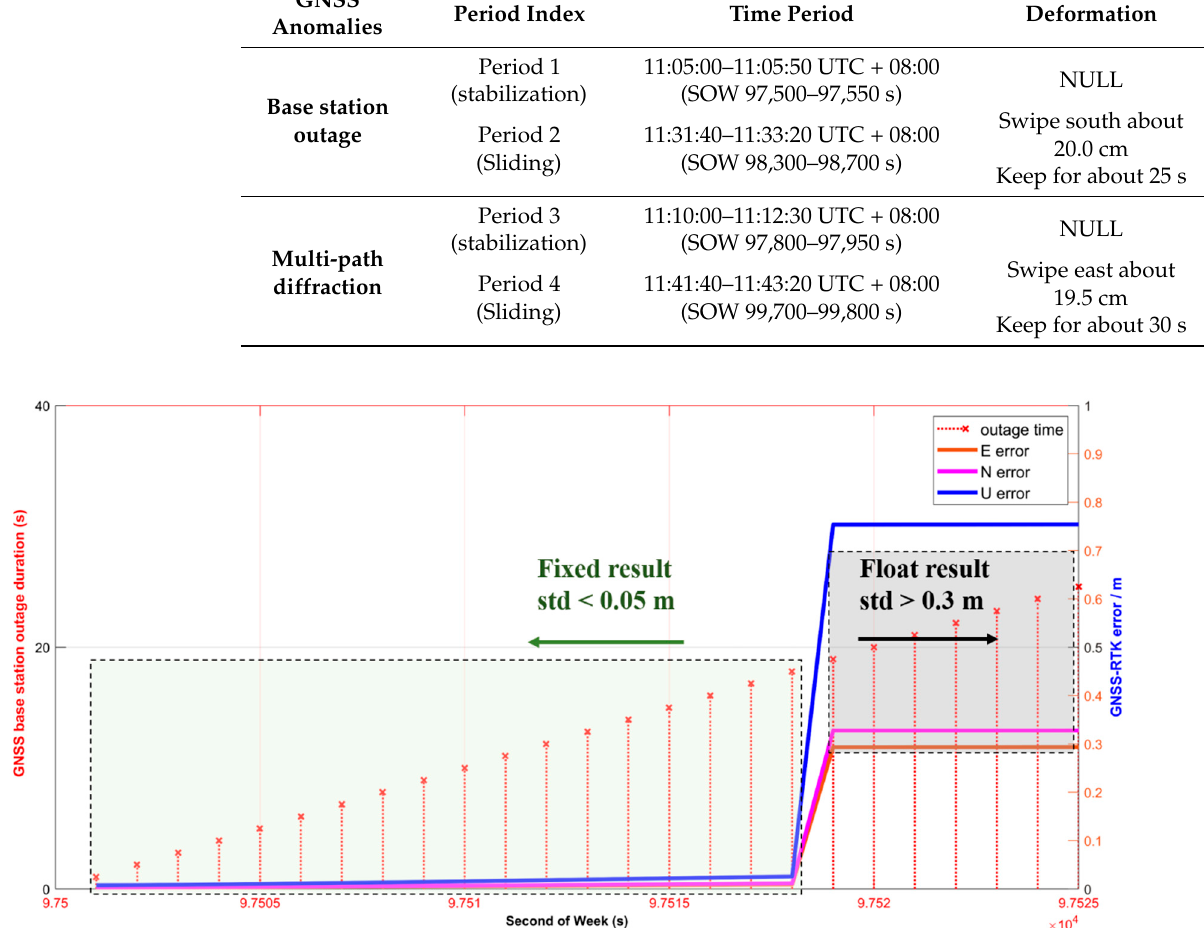
Figure 7. The relationship between the base station outage duration and the covariance.